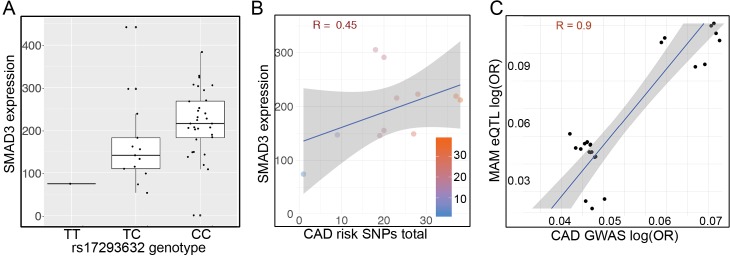
SMAD3 expression is directly correlated with disease risk.A) HCASMC eQTL data was employed to investigate the directionality of associated disease variation on SMAD3 expression in a highly disease relevant cellular model. The disease risk C allele genotype at rs17293632 was associated with increased SMAD3 expression. This genotype effect on expression was significant at p<0.05 employing a linear regression model. B) To investigate all variation that might contribute to differential expression of SMAD3 and thus disease risk, we studied CAD associated SNPs from the latest CARDIOGRAM+C4D meta-analysis [7] that were associated with CAD at p<1.0e-6 and that were located up to 100kb away from the SMAD3 gene. This regression analysis with HCASMC eQTL data had a Perrson correlation coefficient of 0.45 and was nominally significant at p = 0.08, suggesting that SMAD3 expression increases with a greater number of cis-risk alleles as per an additive model and further implicate SMAD3 expression and function in disease risk in this cell type. C) All CAD associated SNPs at p<1.0e-4 from Nelson et al. [7] that were identified in the cis-eQTL summary results, having some association with SMAD3 expression levels in artery tissues (internal mammary artery; MAM) in individuals with CAD from the STARNET study were plotted relative to each other based on their respective effect sizes (log OR) [60]. Pearson correlation coefficient R = 0.894, p = 3.76e-9.